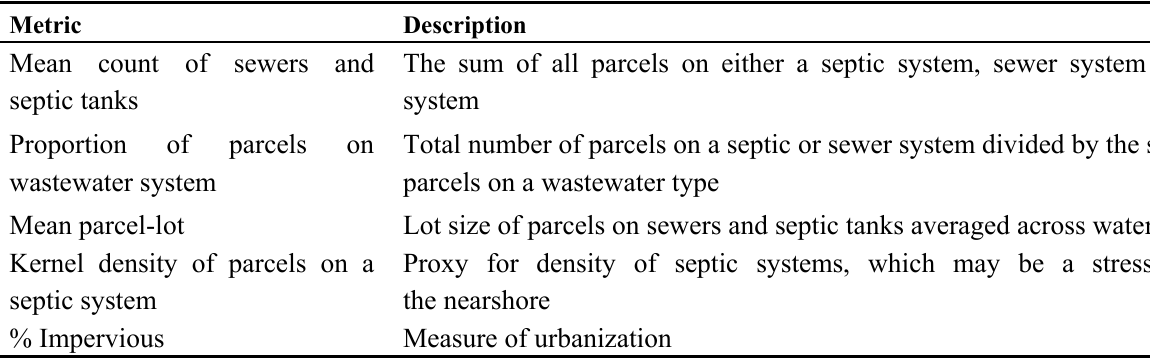
Table 1. Spatial